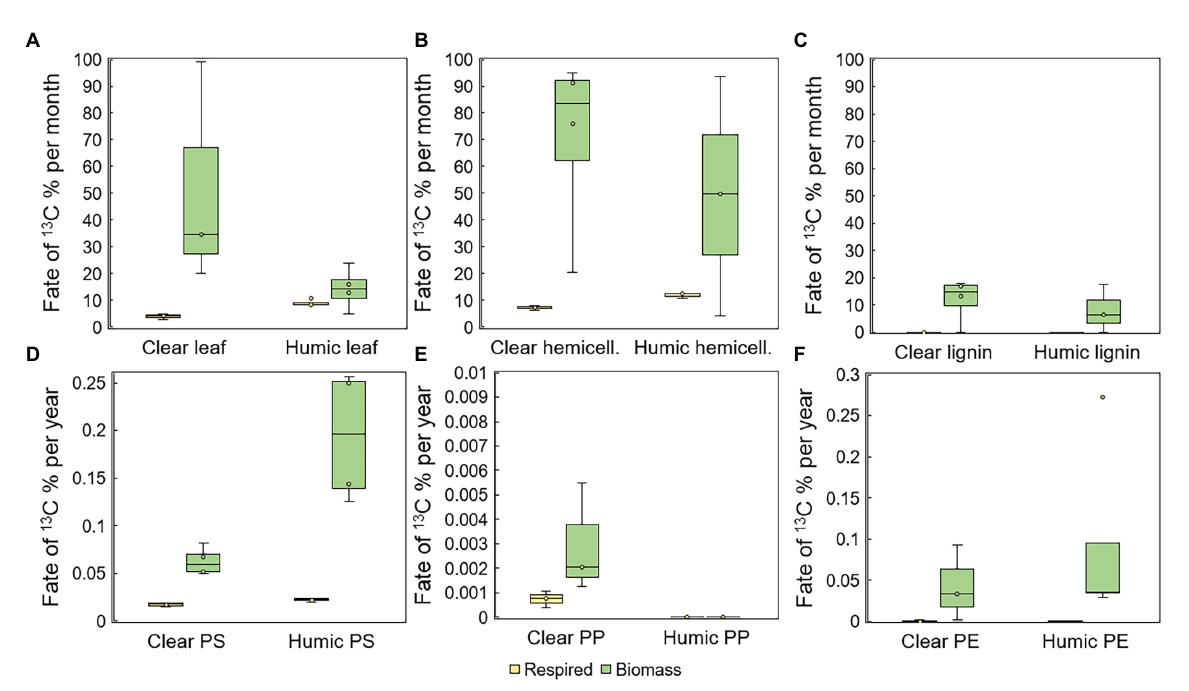
FIGURE 3 Assimilation and mineralization of 13 C-labeled (A) leaves, (B) hemicellulose, (C) lignin, (D) PS, (E) PP, and (F) PE. In humic lake water n = 4 for leaf, PS, PP, and PE treatments and n = 3 for lignin and hemicellulose. In clear lake water n = 4 for lignin, hemicellulose, and PS treatments and n = 3 for leaf, PP, and